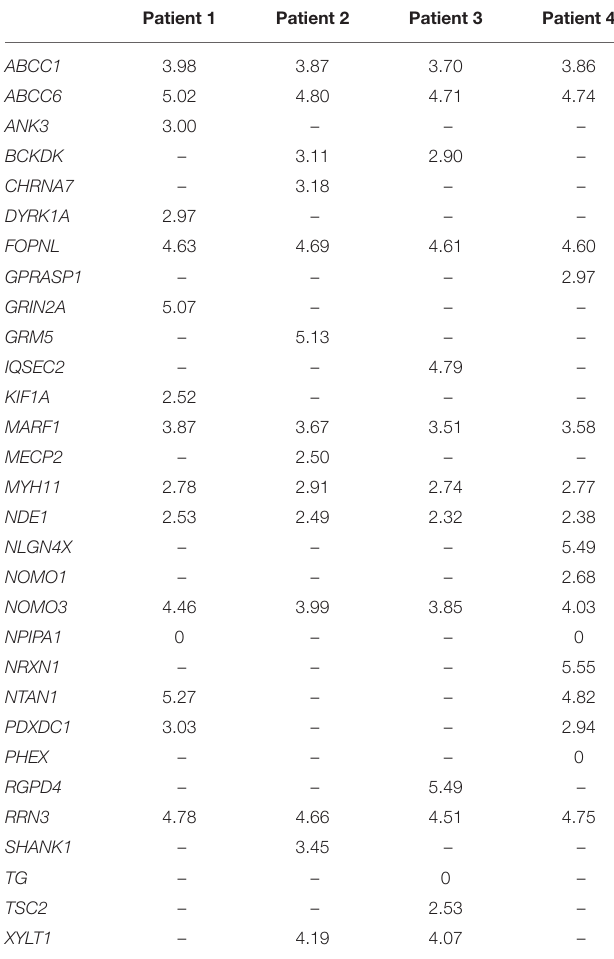
TABLE 2 | Betweenness centrality values ( − log 10 ) of all signature